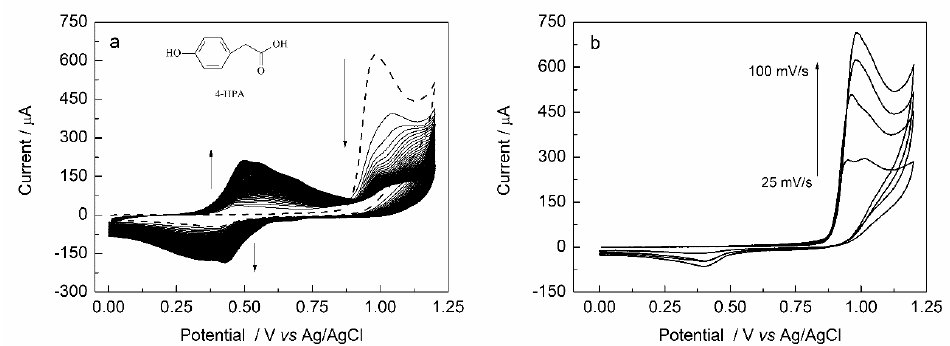
Figure 1. Cyclic voltammograms recorded in 0.5 M perchloric acid solution containing 2.5 mM 4-HPA: ( a ) 100 scans at 75 mV/s. (---) First scan. Arrows indicate the current direction; and ( b ) 1st scan at different scan rates (25, 50, 75, and 100 mV/s).